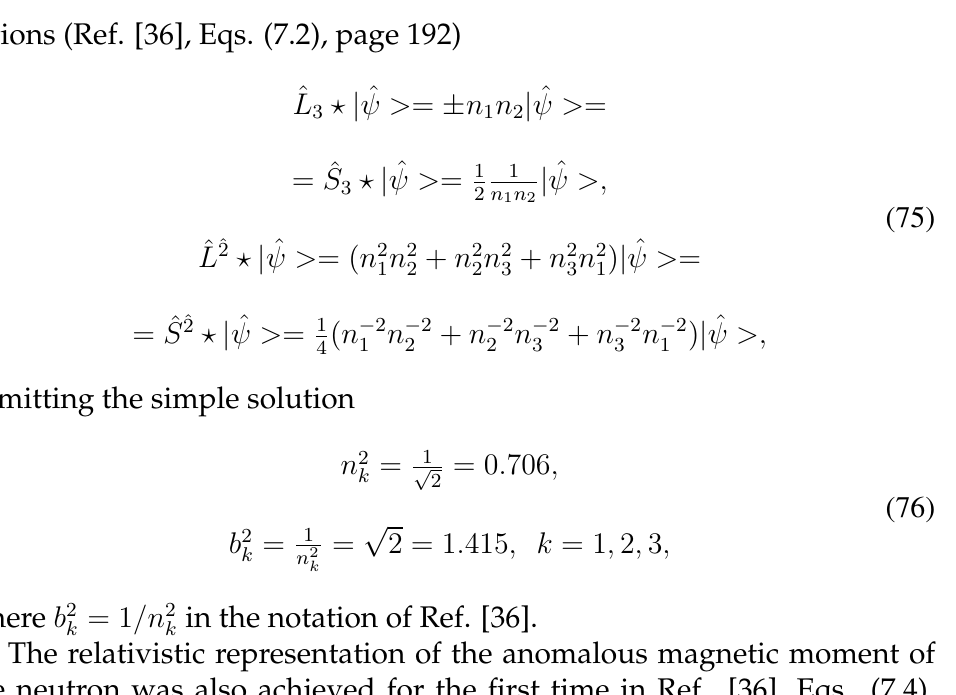
Figure 12: An illustration of the compatibility of the quantum mechanical SU (3) and subsequent classifications of baryons unto families, and the structure of individual baryons as a hadronic bound state with physical constituents generally emitted free in the spontaneous decays with the lowest mode, Eqs. (241). Said compatibility is achieved via the multi-valued hyperunit characterized by the isounits or isotopic elements of the individual baryons, Eqs. (242), and its use to build the hyperstructural image of the ap- plicable Lie symmetry that turns out to be locally isomorphic to the original symmetry due to the positive-definite character of the